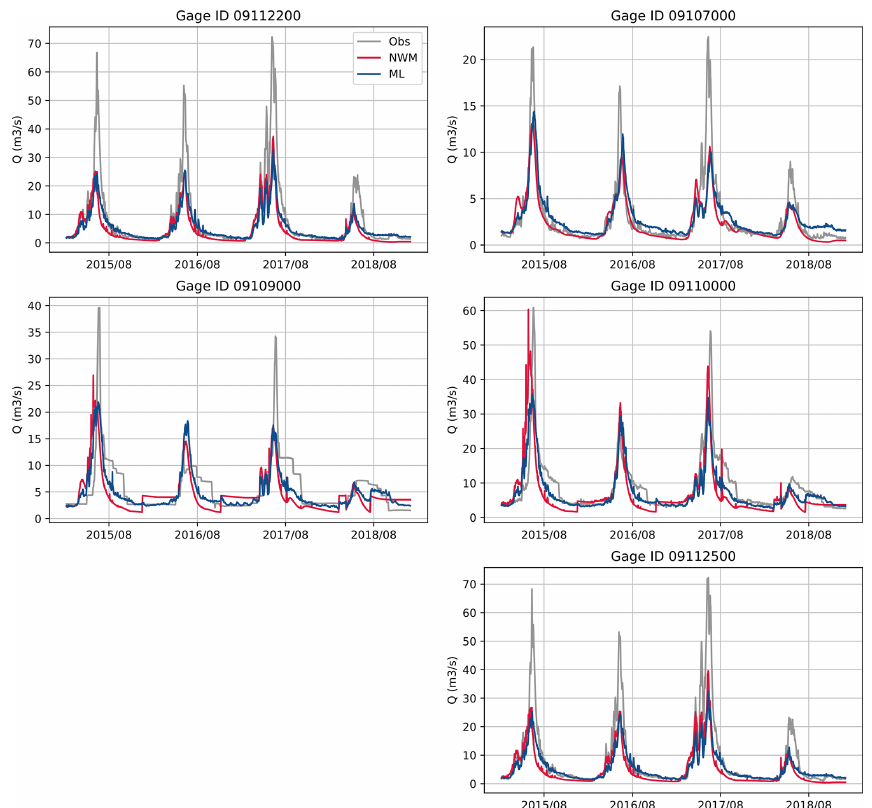
Figure 7. Hydrographs simulated by the NWM (dark blue) and GWN-O (ML, dark red) vs. the USGS data (Obs, gray) over the testing